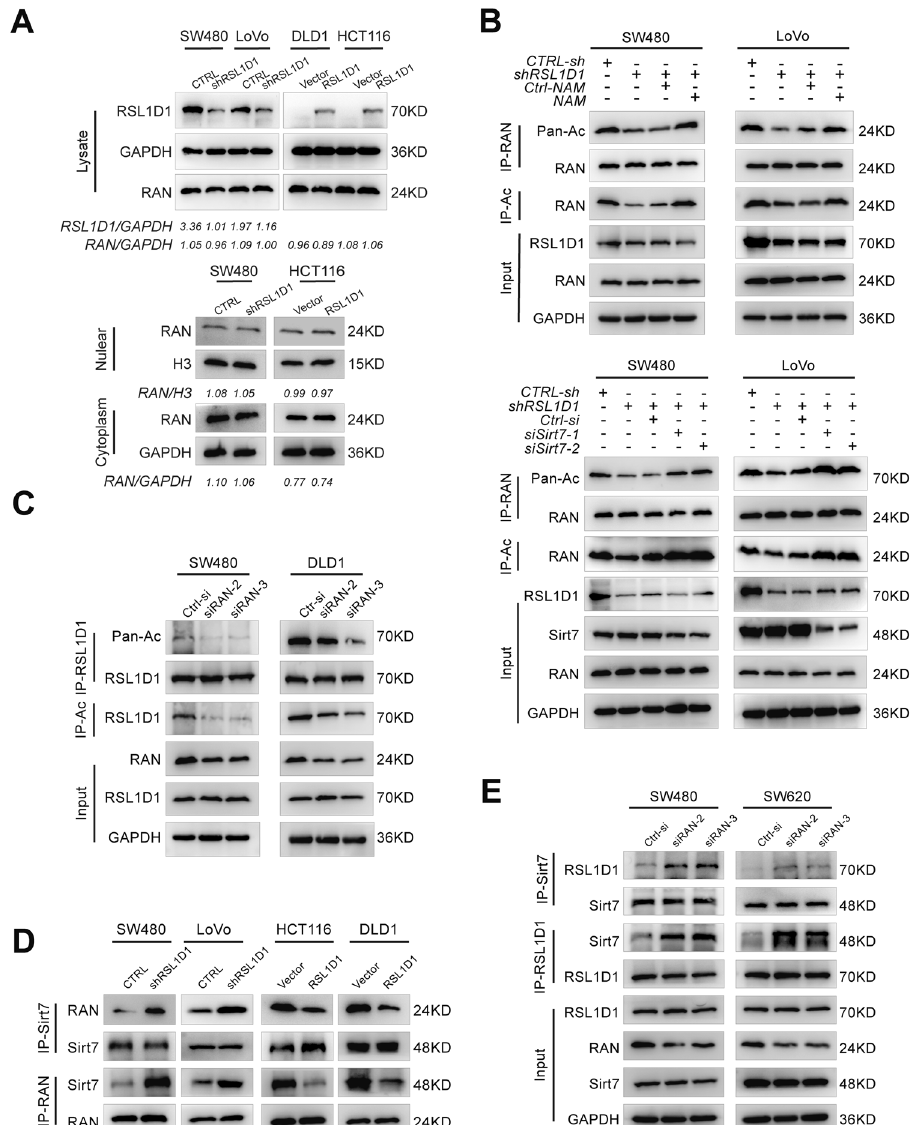
Fig. 7 RSL1D1 inhibits the deacetylation of RAN by competitively binding with Sirt7. A Total/nuclear/cytoplasmic extraction and western blot analysis of RAN expression in CRC cells after RSL1D1 knockdown and overexpression. B Acetylation of RAN in CRC cells after RSL1D1 knockdown and treatment with the deacetylase inhibitor NAM or transfection with siRNA-Sirt7. C Acetylation of RSL1D1 in CRC cells transfected with siRNA-RAN. D Co-IP of the interaction between RAN and Sirt7 in CRC cells after RSL1D1 knockdown or overexpression. E Co- IP of the interaction between RSL1D1 and Sirt7 in CRC cells after transient RAN